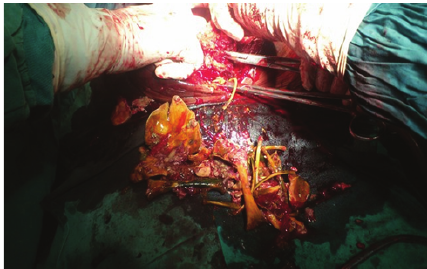
Figure 2: Intra operative evacuation of fetal bones.